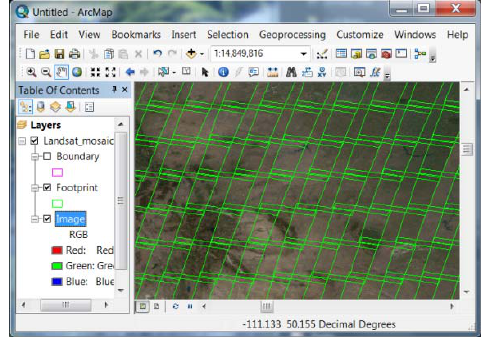
Figure 7. Catalog and mosaic view of a mosaic dataset created from Landsat 7 ETM+